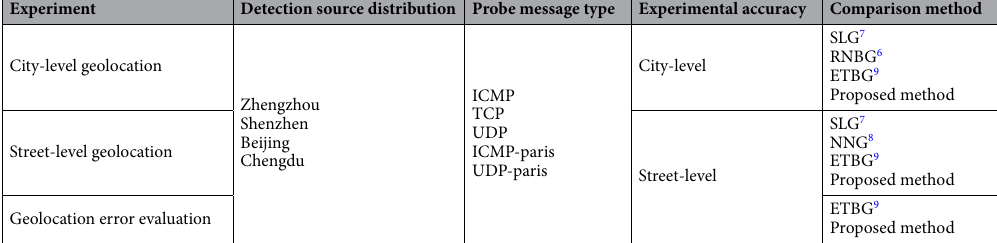
Table 4. Experimental setup.